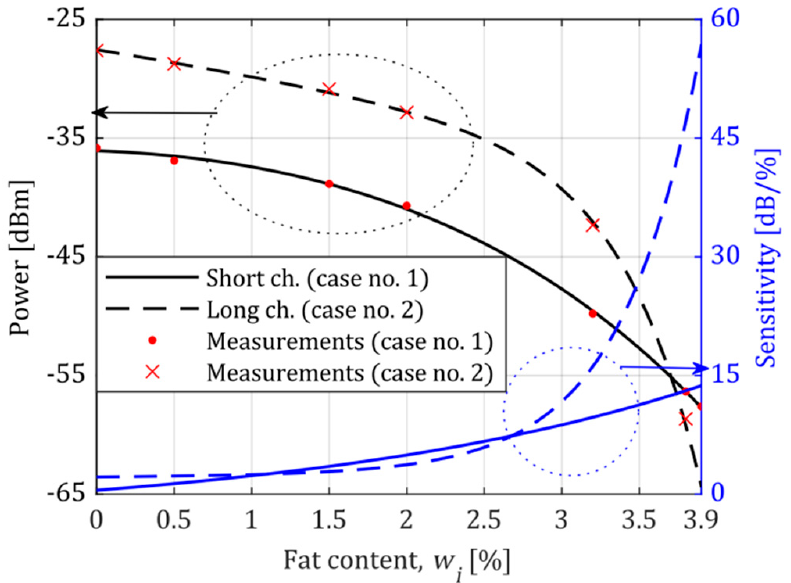
Figure 7. The standard curve and sensitivity curve for the fat content of milk. The system’s operating point was set at 3.9% of the milk fat. (Black curves denote power, and sensitivity is represented by blue curves, similarly to the axis colours. To distinguish measurements in the short channel “.” marker is used, whereas long channel measurements are marked by “x”).